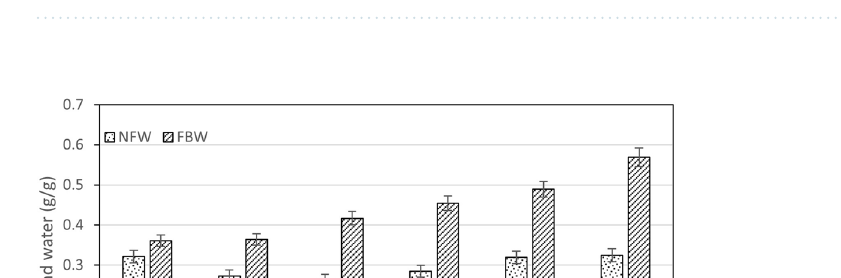
Table 1. Thermoporosimetry results in fibers and vessels, treated and untreated.